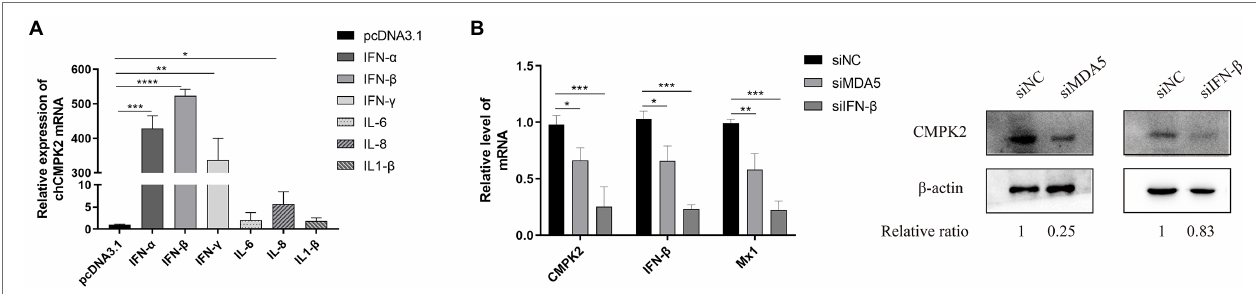
FIGURE 6 | The expression of chCMPK2 is dependent on MDA5/IFN- β pathway. (A) The mRNA level of CMPK2 in DF-1 cells was tested by qRT-PCR after transfection with pcDNA3.1 (control), IFN- α , IFN- β , IFN- γ , IL-6, IL-8, and IL-1 β for 12 h. (B) DF-1 cells were treated with control siRNA (siNC) or small interfering RNA (siRNA) targeting chicken MDA5 and IFN- β to knock-down the expression of MDA5 and IFN- β . Cells were then stimulated with poly(I:C) for 12 h at a concentration of 1 μ g/ml, and the mRNA levels of CMPK2 , IFN- β , and Mx1 were measured via qRT-PCR. The protein of CMPK2 was detected via WB. The gray intensity for each band was measured, and the relative ratio of CMPK2 was determined from the equation (Sample CMPK2 /Sample actin )/(Mock CMPK2 /Mock actin ) and marked at the bottom of each lane. Values represent the mean of the individual measurements in each sample ± SEM. * p < 0.05, ** p < 0.01, *** p < 0.001, and **** p <